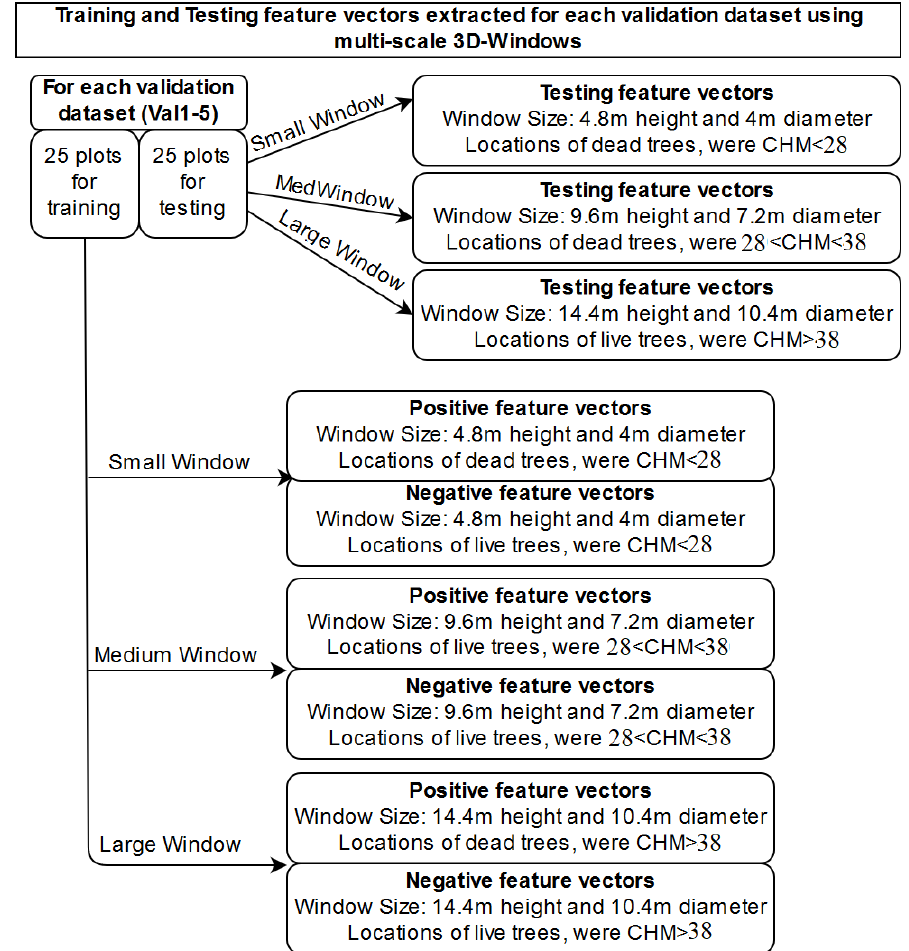
Figure 7. Feature vectors extracted for training and validating the multi-scale 3D-windows